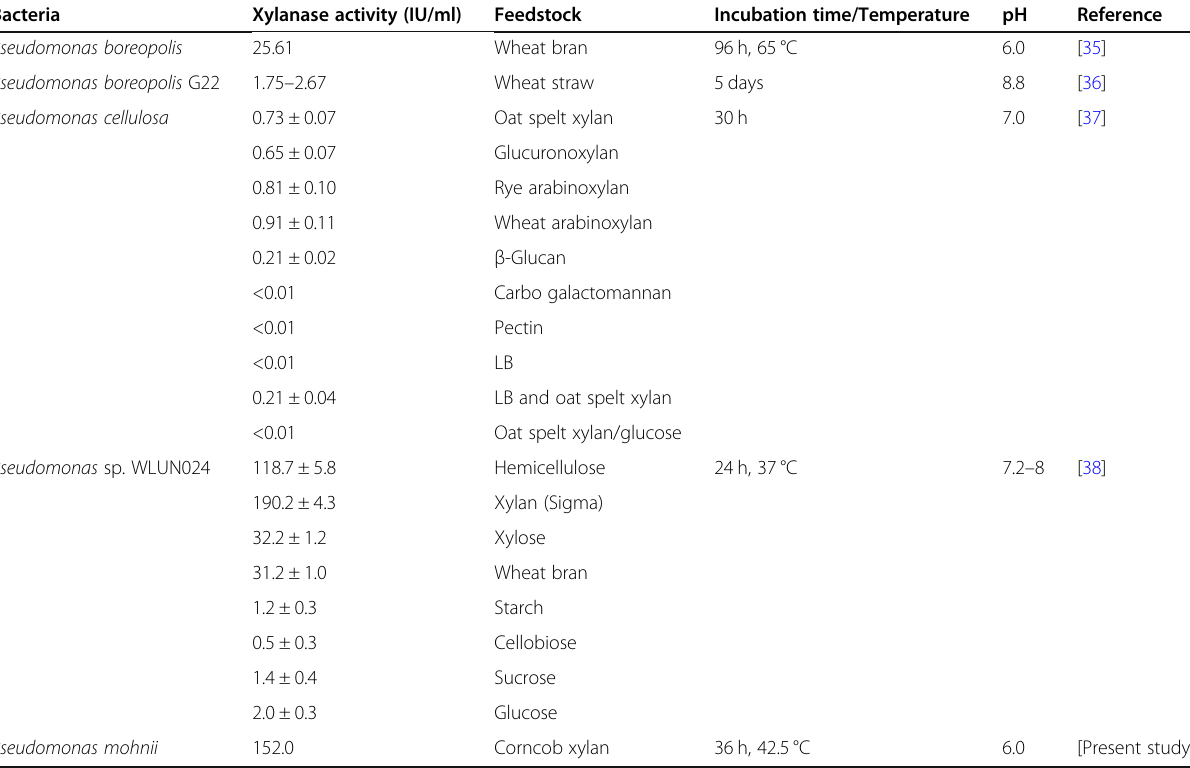
Table 7 Comparison of xylanase production by different Pseudomonas